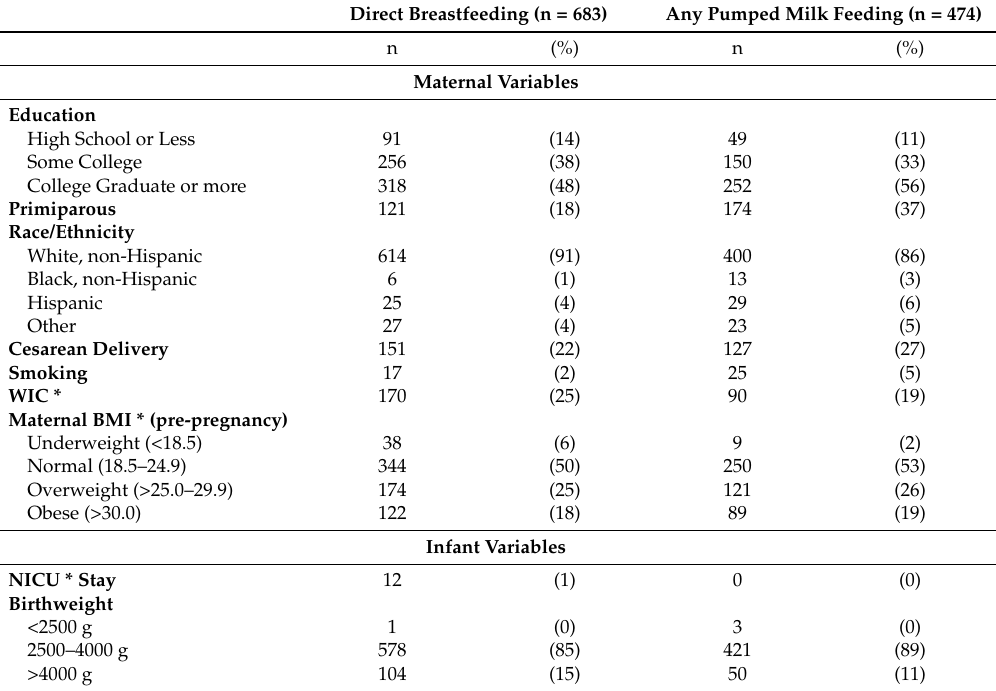
Table 1. Maternal and infant descriptive characteristics for participants who were exclusively breast milk feeding when they completed the newborn questionnaire for the Infant Feeding Practices Survey II (IFPS II), 2005–2007.